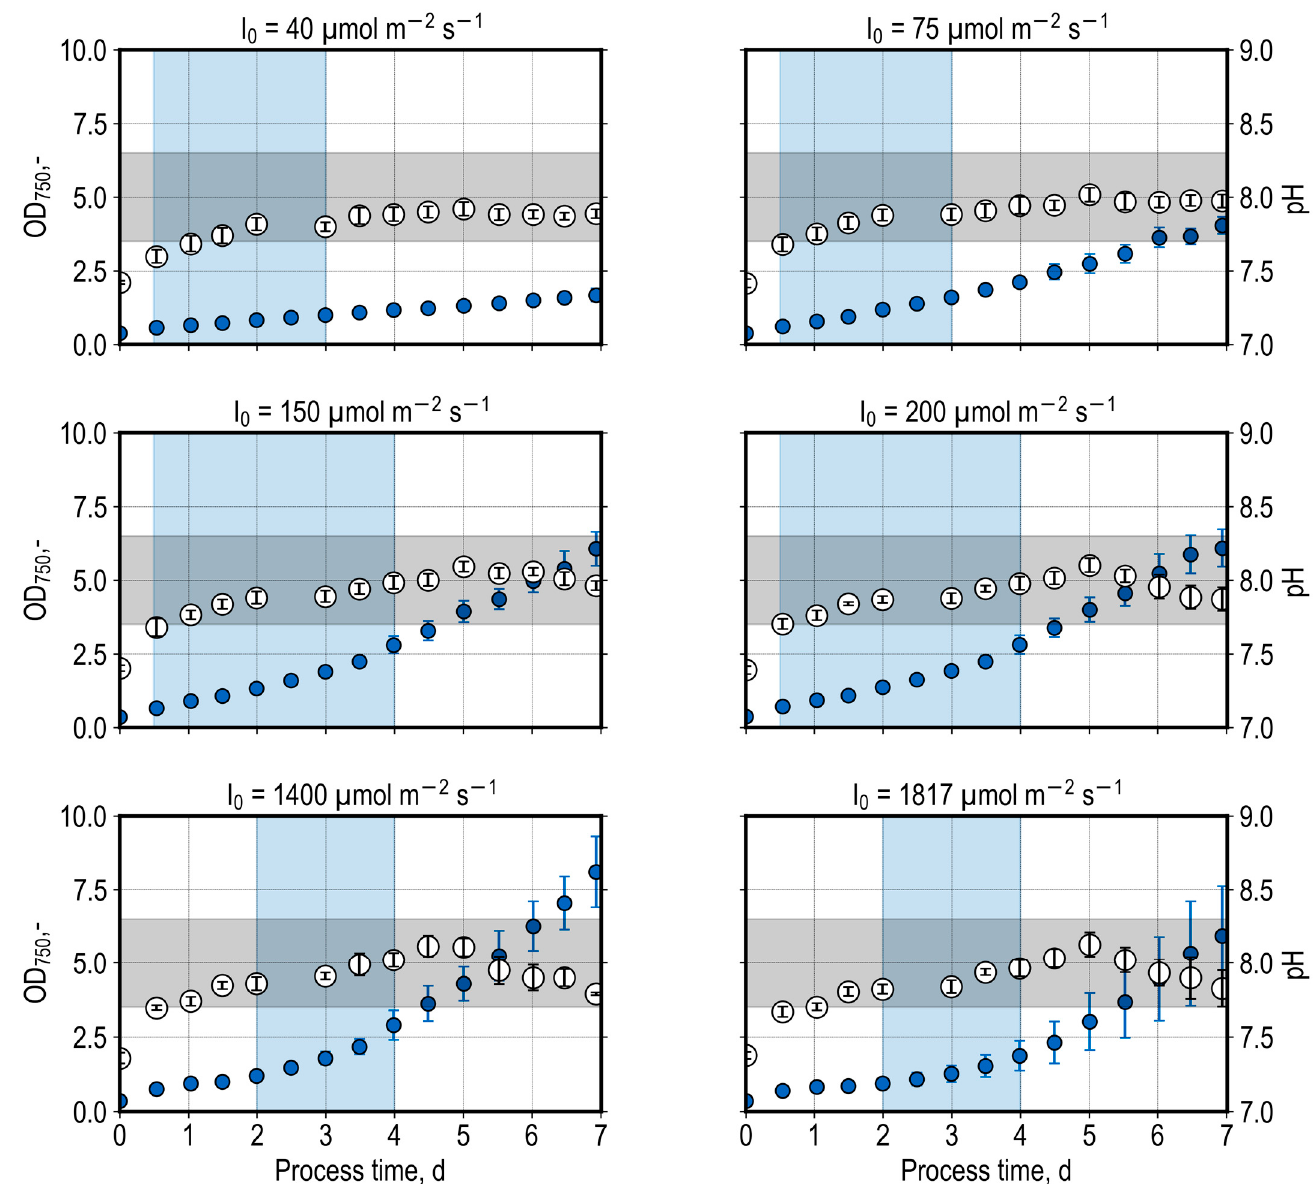
Figure 7. Automated photoautotrophic batch cultivation of M. salina in miniaturized stirred-tank PBRs. Each row of eight bioreactors in the bioreaction unit was illuminated at six different incident light intensities I 0 . Each bioreactor was initially filled with 10 mL of M. salina suspension in an ASW medium with an initial OD 750 of 0.5 (initial pH 8 + 0.3). Magnetically induced S-stirrers were employed at 500 rpm. The head space of the 48 parallel stirred-tank bioreactors was rinsed with 288 L h − 1 of sterile air with 2% CO 2 . The blue vertical shading indicates the exponential growth phase used to estimate the individual exponential growth rates as a function of the incident light intensities. Mean OD is represented by blue circles, whereas pH is represented by white circles. If the at-line-measured pH was below pH 7.7 or above pH 8.3 (horizontal gray-shaded area), either 45 µ L of base (0.5 M NaOH) or acid (0.5 M HCl) was added to the relevant bioreactor by the